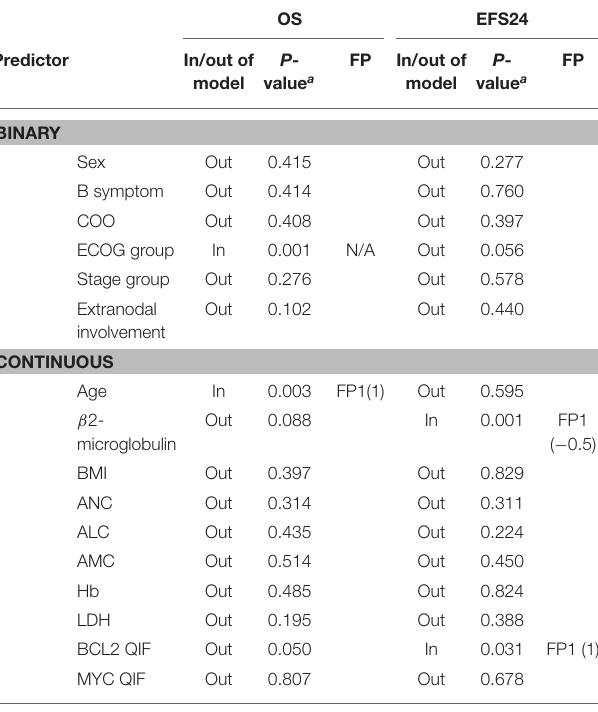
TABLE 3 | Numbers and percentages of selected powers from 1,000 bootstrap replications.